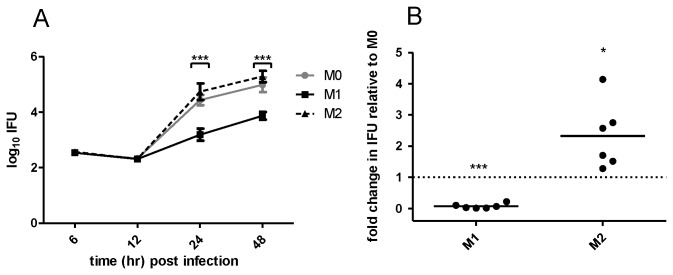
M1 macrophages demonstrate lower
Chlamydia
 load than M0 and M2 macrophages.Polarized BMDM were infected for the indicated time points. (A)
Chlamydia
 growth seen at 24 and 48 hr p.i. was significantly higher in M0 and M2 macrophages versus M1 macrophages as determined by repeated measures two-way ANOVA with Boneferroni post-test. Data is mean ±SEM from three independent experiments. (B) At 24 hr p.i. M2 macrophages contain significantly more IFU than M0 macrophages whilst M1 macrophages contain less. As inter-experimental IFU differed, IFU in M1 and M2 normalized to that in M0 prior to analysis. Data is mean ±SEM from six independent experiments and analyzed by one-sample t-test against hypothetical value of 1.0.